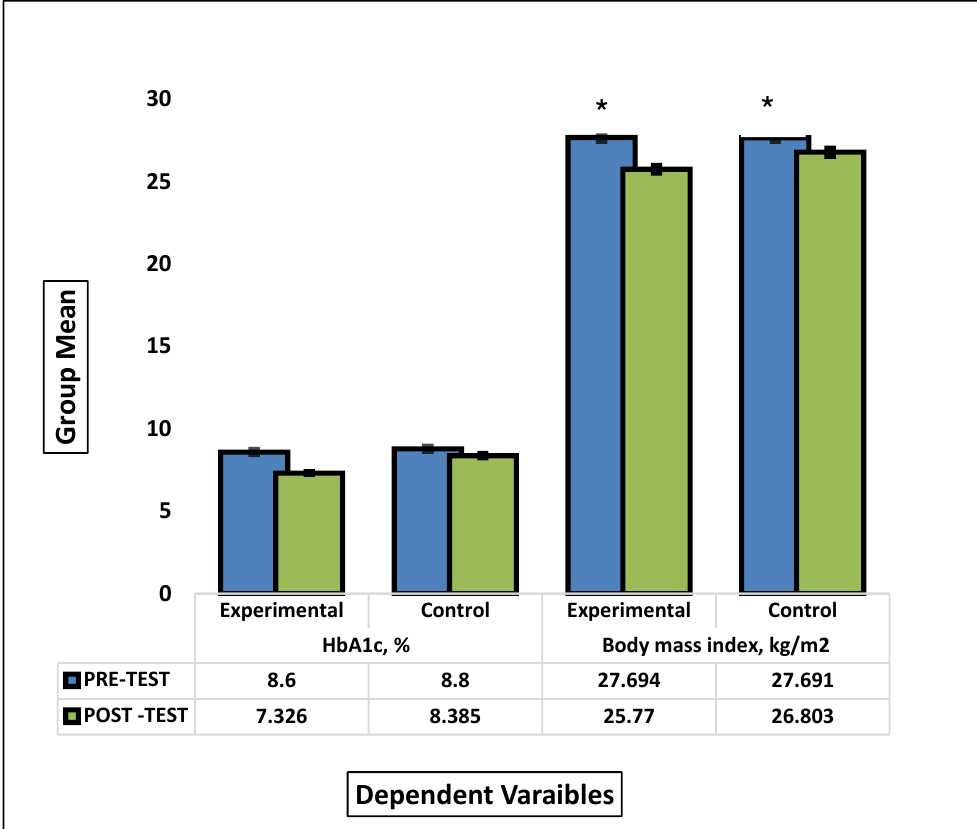
Figure 2. Comparison between the group means of HbA1c and BMI before and after the intervention. * signify statistical significant different between pre-test and post test mean scores of experimental and control groups.